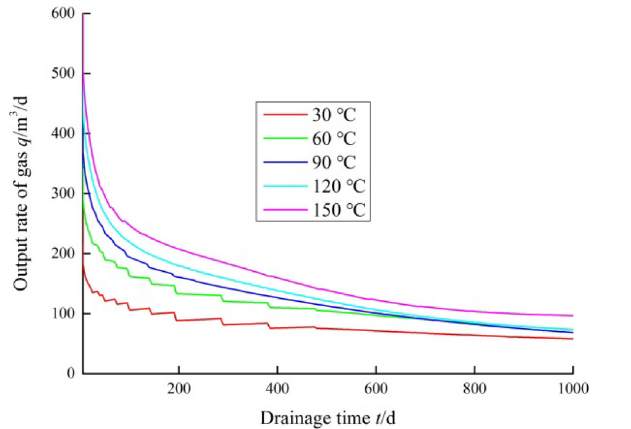
Fig. 8 Output rate of gas versus drainage time